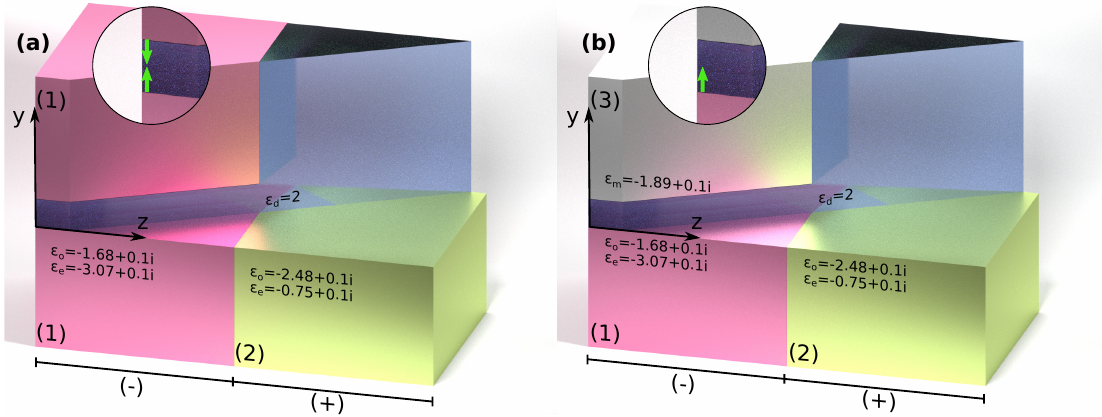
Figure 6. Geometry for the two pseudocanalizing systems, with symmetric ( a ) and nonsymmetric ( b ) three layer system, with anisotropic media indicated by (1) and (2) and the metal for asymmetric system shown with (3). Insets indicate placement of dipole sources to excite the waves. In ( a ) the sources are aligned such to only excite the odd mode. (+) and (-) indicate regions with normal and reversed phase propagation,